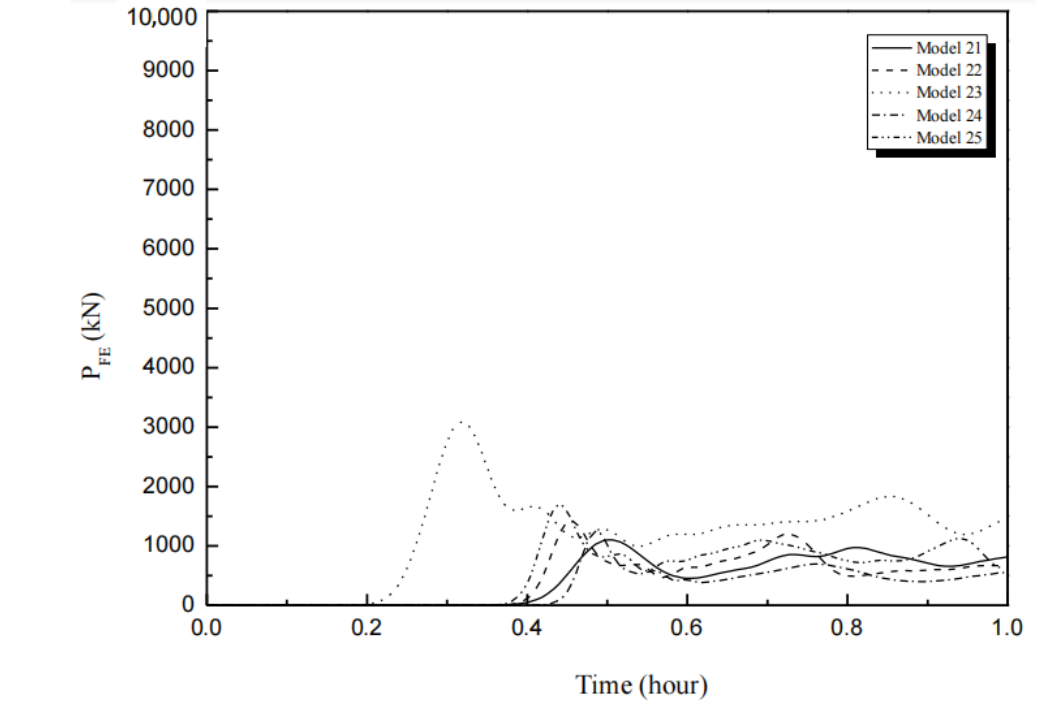
Figure 6. Axial strength versus time for model numbers 21–25.